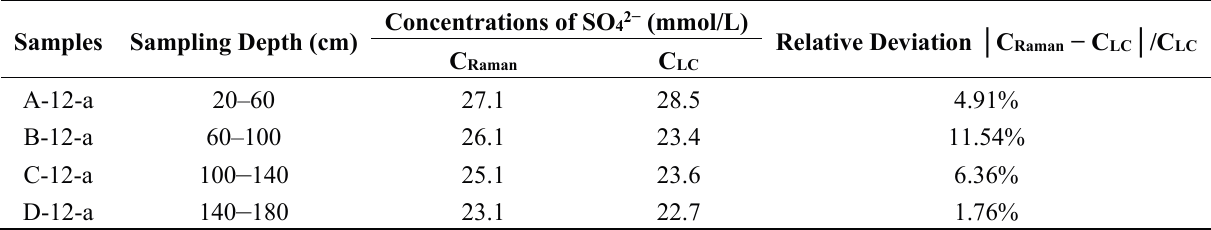
Table 1. Concentrations of SO 42 − in pore water samples measured by Raman spectroscopy and liquid chromatography.